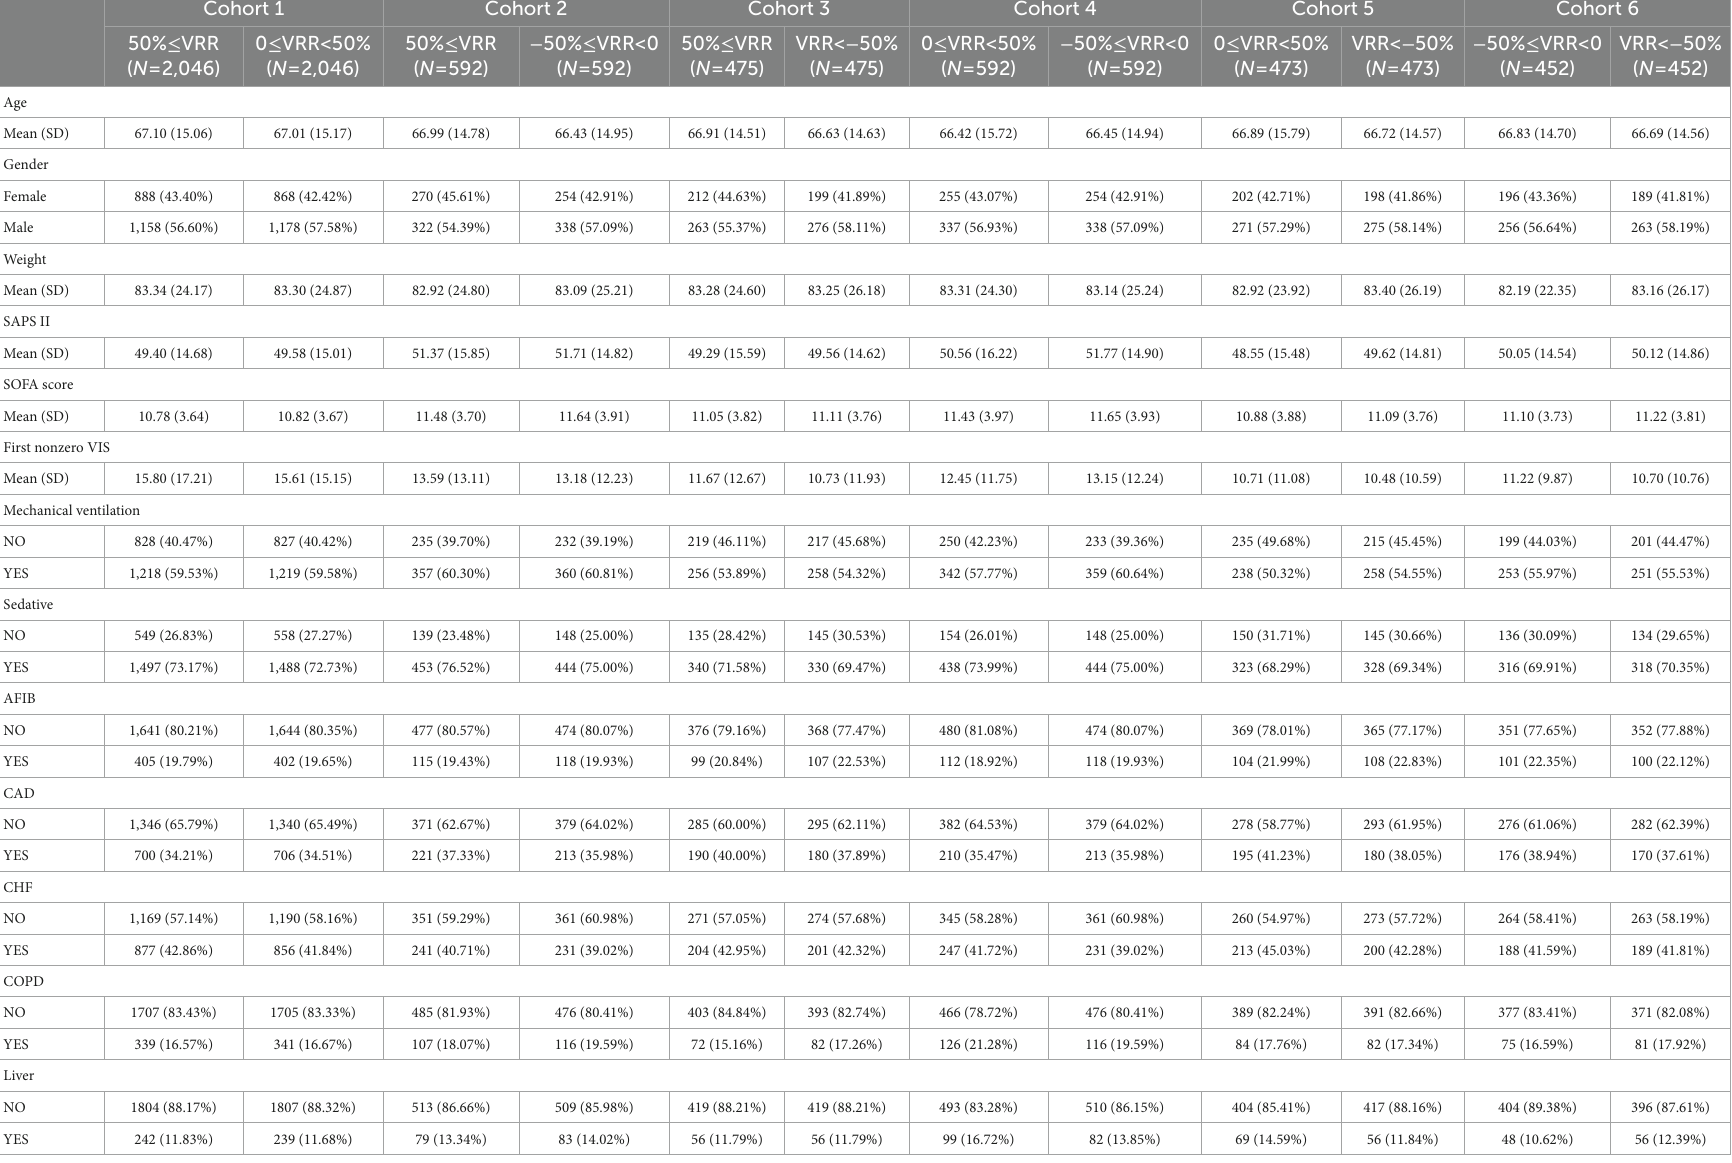
TABLE 1 Basic demographic of matched 6 cohorts after multiple